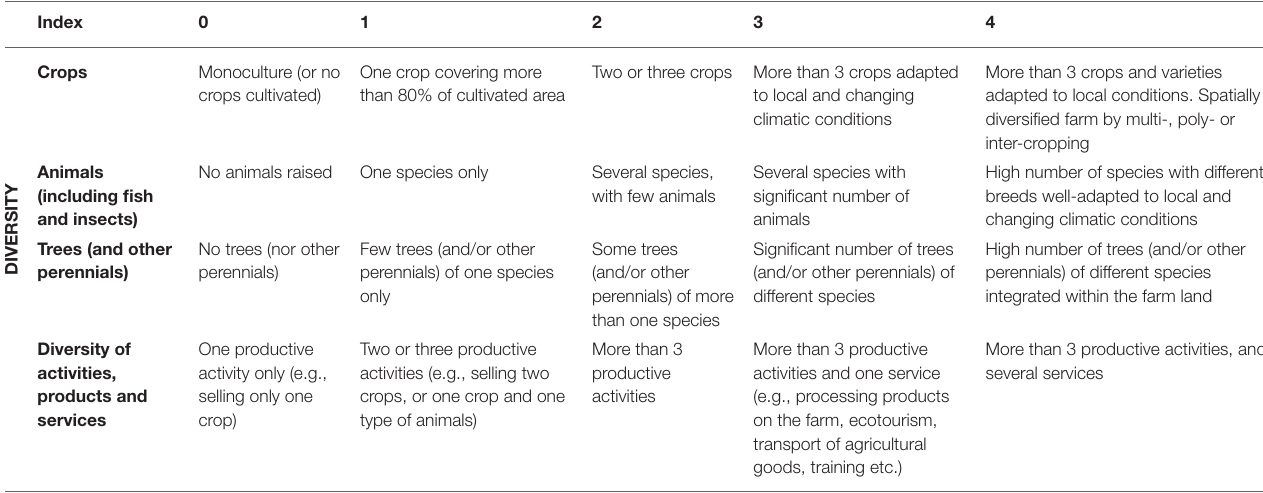
TABLE 2 | Characterization of agroecological transitions (CAET): Descriptive scales and scores for the element